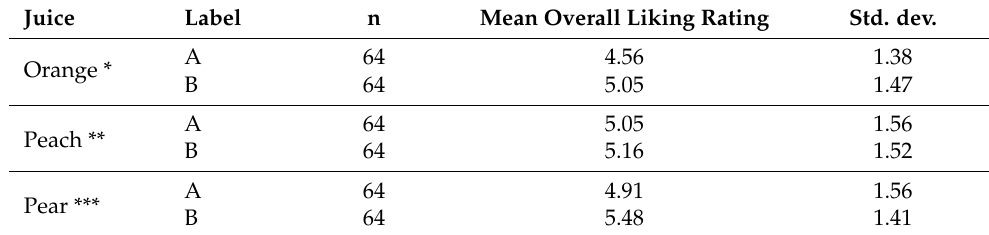
Table A3. Overall liking rating for the tasted juices. Juice Label n